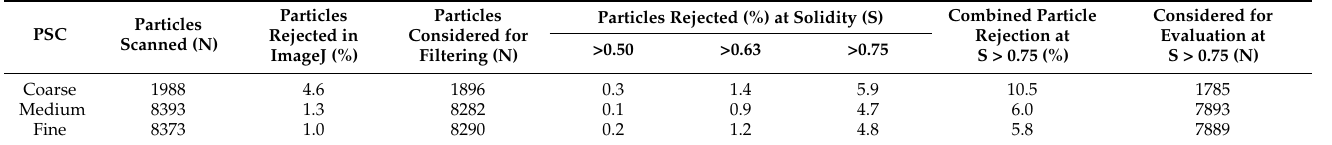
Figure 5. Disjointed areas (islands) ( a ) and incomplete particle selection ( b ) led to the rejection of some voluminous particles in ImageJ. Table 5. Gradual refinement of particle counts in preparation for the granulometry